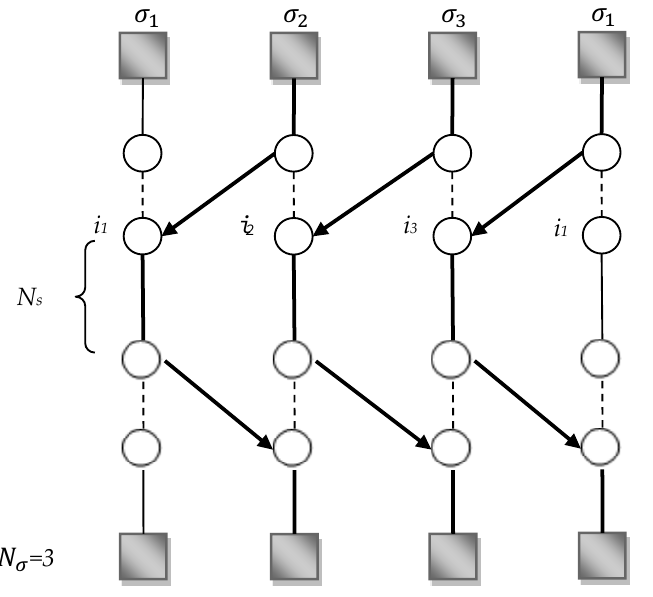
Figure 3. Cyclic exchange with three routes ([50]).